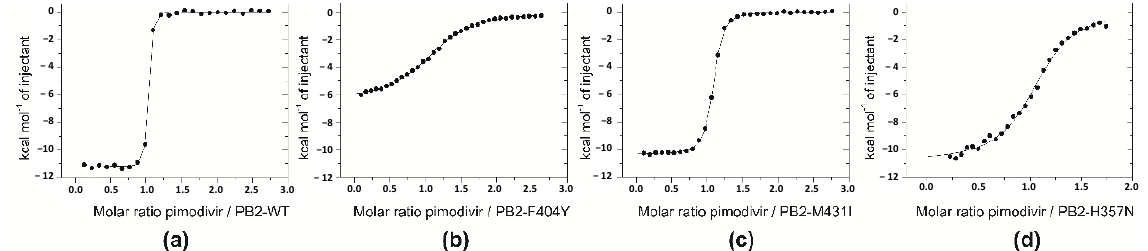
Figure 3. Thermodynamic analyses of pimodivir binding to mutant PB2 cap-binding domains. Isothermal titrations of pimodivir to the cap-binding domain of PB2-WT ( a ), PB2-F404Y ( b ), PB2-M431I ( c ), and PB2-H357N ( d ) performed in 20 mM PIPES, pH 7.5, 150 mM NaCl, 1% DMSO at 25 ◦ C. Table 1. Thermodynamic parameters of pimodivir binding to wild-type cap-binding domain of PB2 influenza A polymerase subunit and mutated variants (F404Y, M431I, H357N). Binding values are means and s.d. of two independent